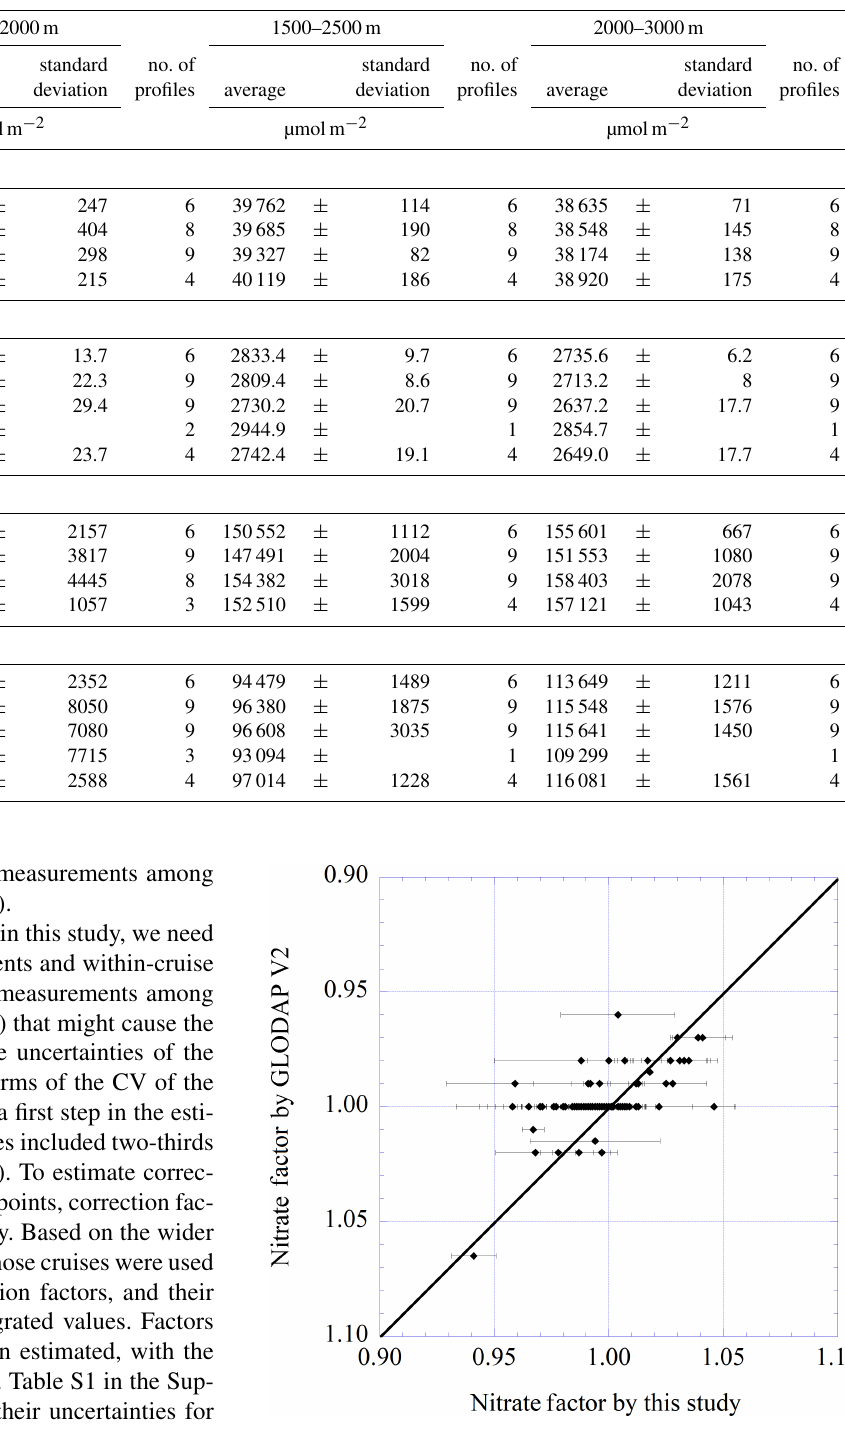
Table 3. Examples of vertical integration between depths of 1000 and 2000m, 1500 and 2500m, and 2000 and 3000m for nitrate, phosphate, silicate, and oxygen concentrations at CR081, P03–P14 crossovers, 24.2 ◦ N, 180 ◦ E.